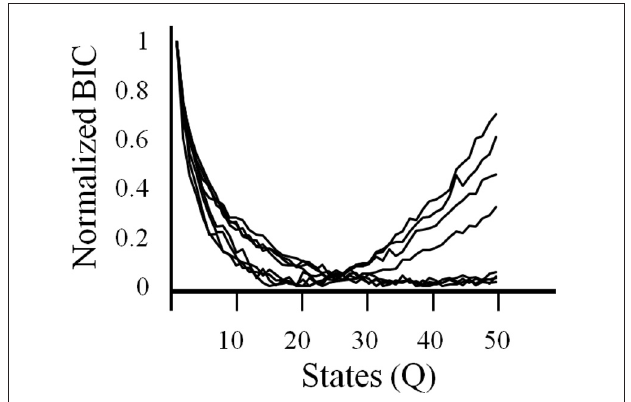
FIGURE 4 | The criteria used to select the number of states in the HMM. A Bayesian Information Criteria (BIC) was used to estimate the optimal number of states (Q) to be used in the HMM for each session. BICs are